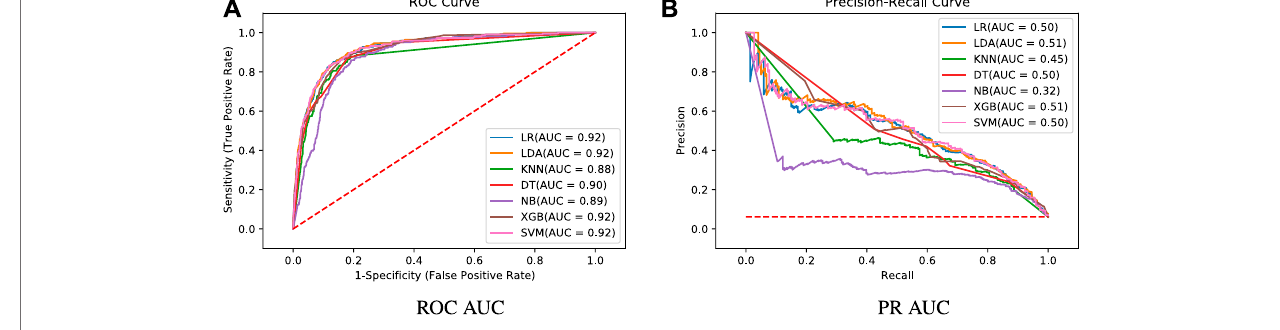
FIGURE 6 | Test results - algorithms comparison.